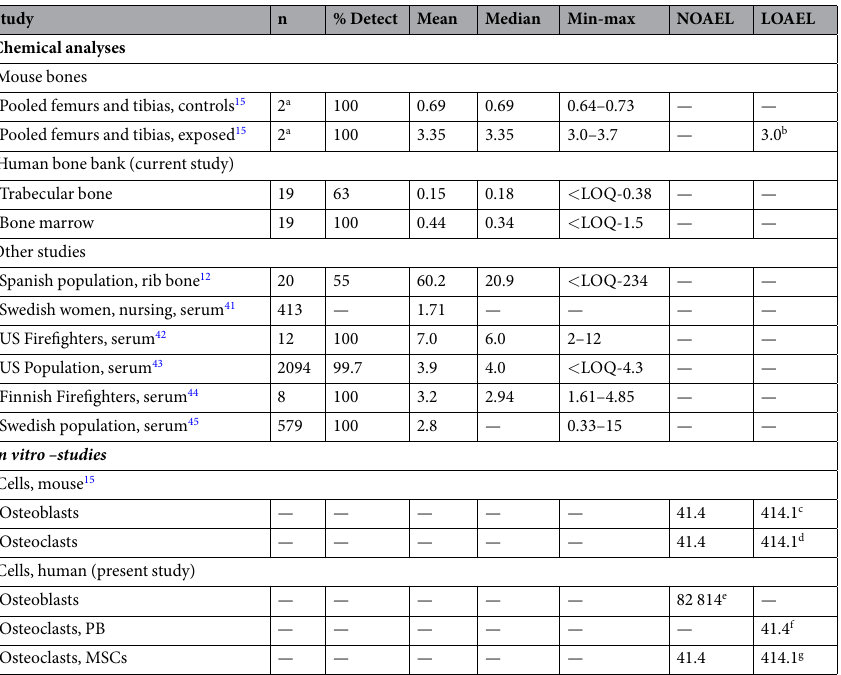
Table 2. Summary of PFOA concentrations (ng/g ww or ng/ml) in mouse and human bone, human serum samples and in in vitro studies of mouse and human osteoblasts and osteoclasts. Data from the present study and the indicated references. NOAEL = no-observed adverse effect level, LOAEL = lowest observed adverse effect level. a Pooled samples from 20 animals, n = 5 in each group. b Increased femoral periosteal and medullary area, decreased cortical mineral density of tibias. c Increased osteocalcin expression. d Increased resorption area. e No significant effects. f Increased number of osteoclasts. g Increased resorption